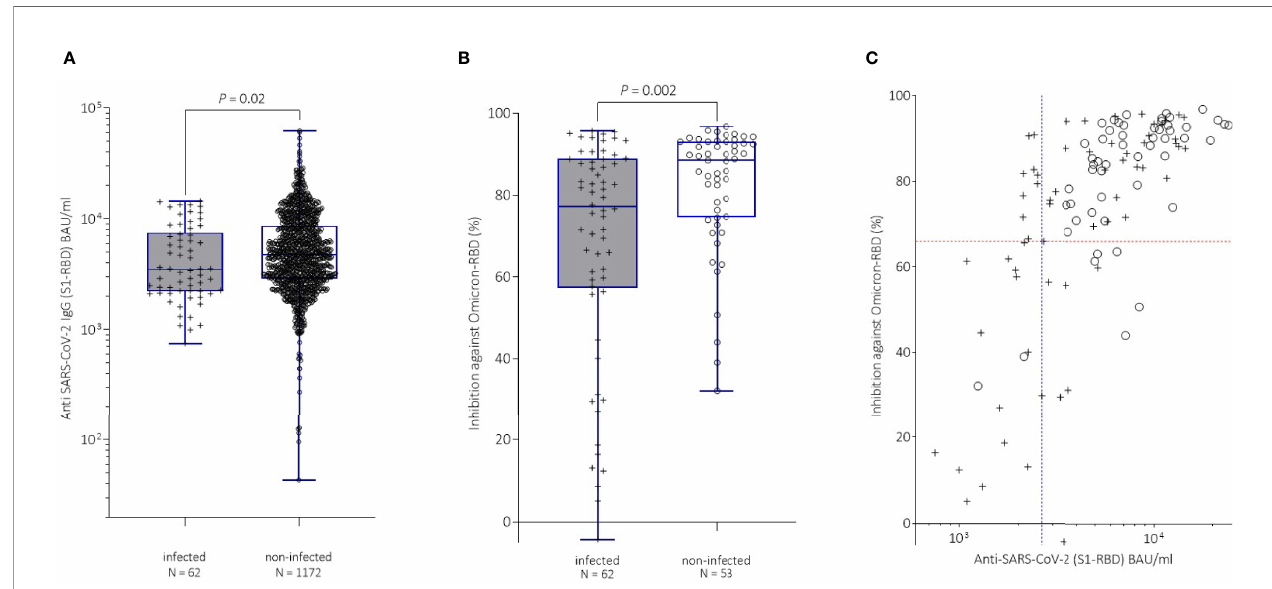
FIGURE 1 | (A) Comparison of anti-spike antibody titers in study participants, with (+, grey boxplots) or without (o, white boxplots) breakthrough infection after the third vaccination. Antibody levels were determined one month after the third vaccination (booster). Median values between infected (3477.0 BAU/ml) and non- infected (4733.0 BAU/ml) individuals differed signi fi cantly (Mann-Whitney test; P = 0.02). (B) Comparison of neutralization capacity as measured by inhibition (%) against Omicron in the study participants with breakthrough infection (+, grey boxplots) with matched non-infected controls (o, white boxplots) after booster vaccination. Median inhibition rates between infected (77.1 %) and non-infected (88.5%) individuals differed signi fi cantly (Mann-Whitney test; P = 0.002). (C) Comparison of anti-spike antibody levels (BAU/ml) with inhibition rates (%) against Omicron-RBD in breakthrough infection cohort (+) and matched non-infected controls (o) by. The red dashed line indicates the 25% percentile (65.9 %) of inhibition rate. The blue dashed line denotes the 25%percentile (2641.0 BAU/ml) of anti- spike antibody